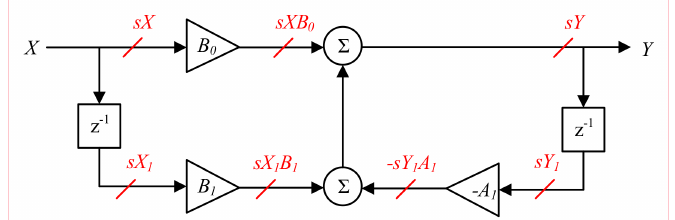
Figure 7. Materialization of the controller based on FIR filter